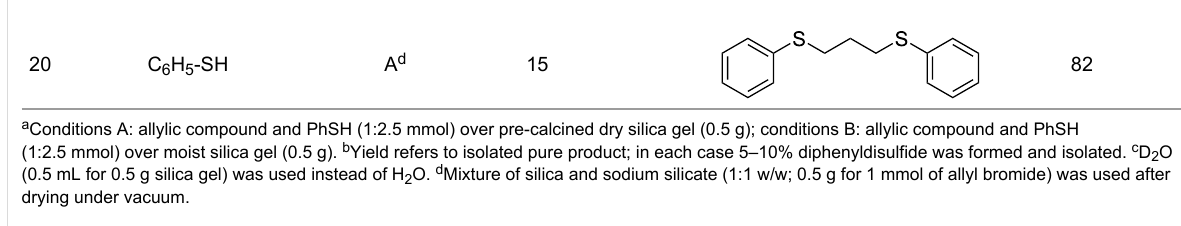
Table 2: Regioselective one-pot synthesis of 1,2 and 1,3-dithioethers using dry (pre-calcined) or moistened silica gel at room temperature. (continued)